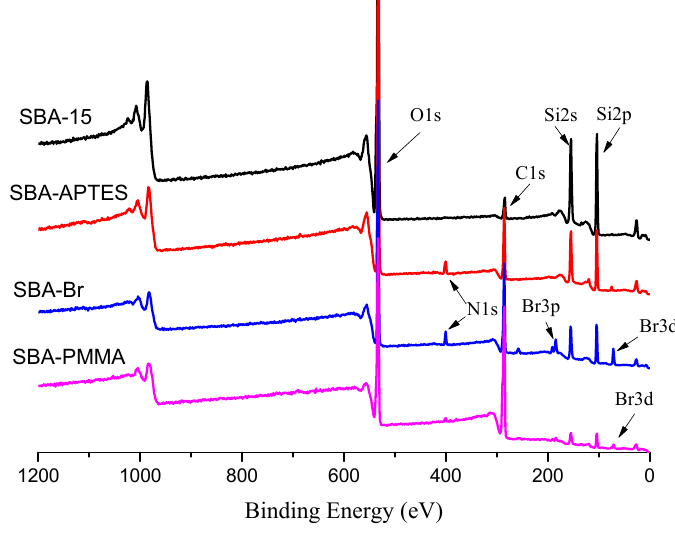
Figure 1. FT-IR spectra of SBA-15, SBA-APTES, SBA-Br, and SBA-PMMA.